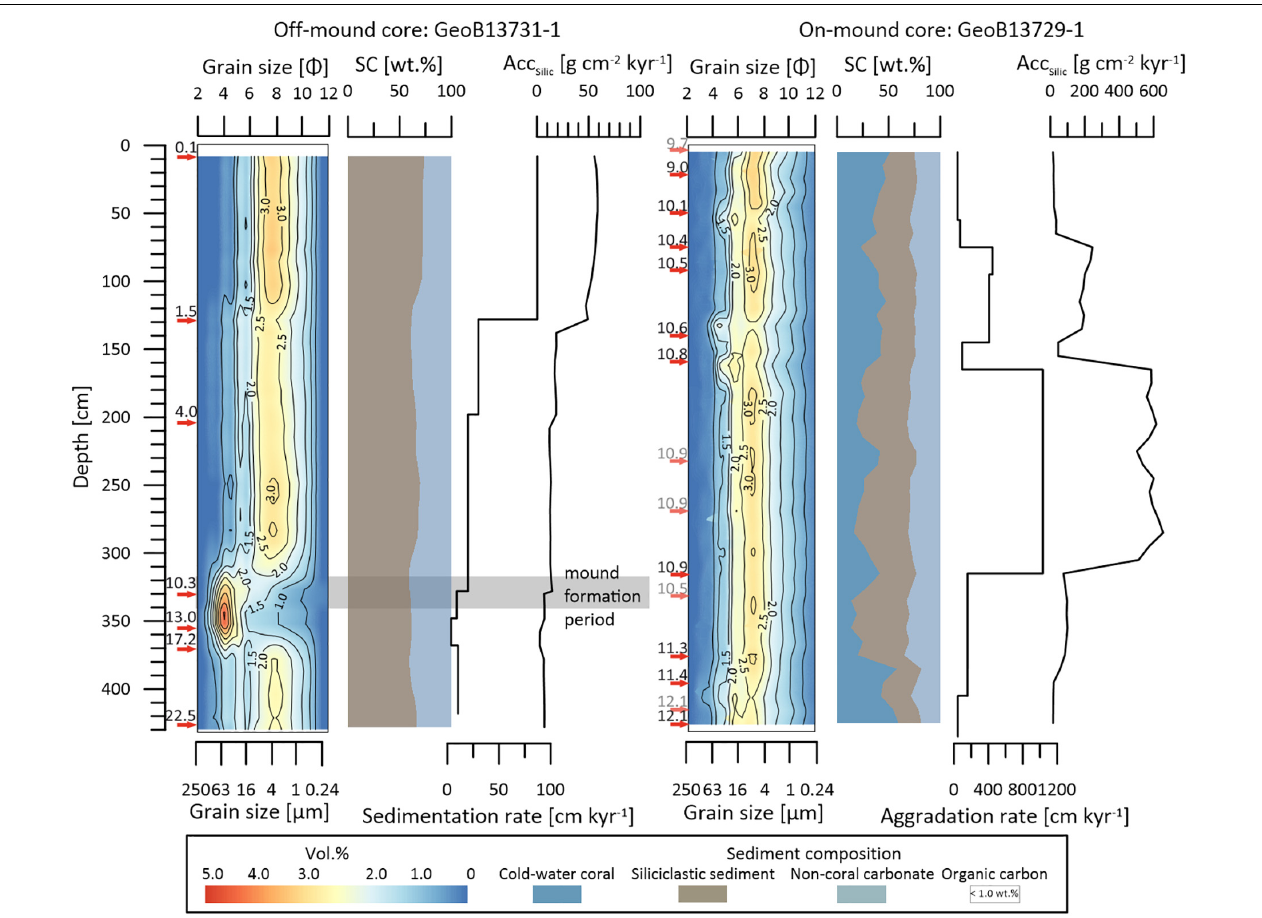
FIGURE 2 | Core logs of the off-mound core GeoB13731-1 and the on-mound core GeoB13729-1. Data obtained from the off-mound core (from left to right): AMS 14 C dates (indicated by red arrows) obtained from mixed planktonic foraminifera, grain size distribution of siliciclastic sediments, sediment composition (SC), sedimentation rate, and accumulation rate of siliciclastic sediments (Acc Silic ). The off-mound core interval temporally corresponding to the mound formation period archived in the on-mound core is highlighted by a gray bar (for detailed comparison see also Figure 3 ). Data obtained for the on-mound core (from left to right): AMS 14 C and U/Th dates (indicated by red arrows) obtained from cold-water coral fragments, grain size distribution of siliciclastic sediments, SC, coral mound aggradation rate, and Acc Silic . Coral ages in gray were not used for the calculation of mound aggradation rate. All 14 C dates were published by Fink et al.